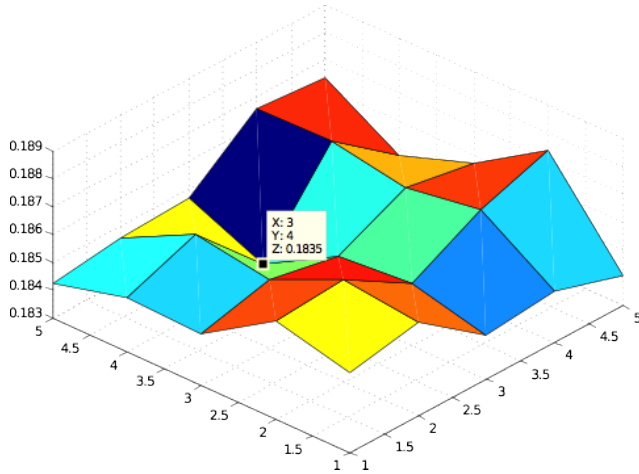
Fig. 6: Grid Search for the Parameters of the Genetic Algo- rithm. X: number of chromosomes for the crossover. Y: number of matrix in the population. Z: the RMSE of the reconstructed signal in the training set.